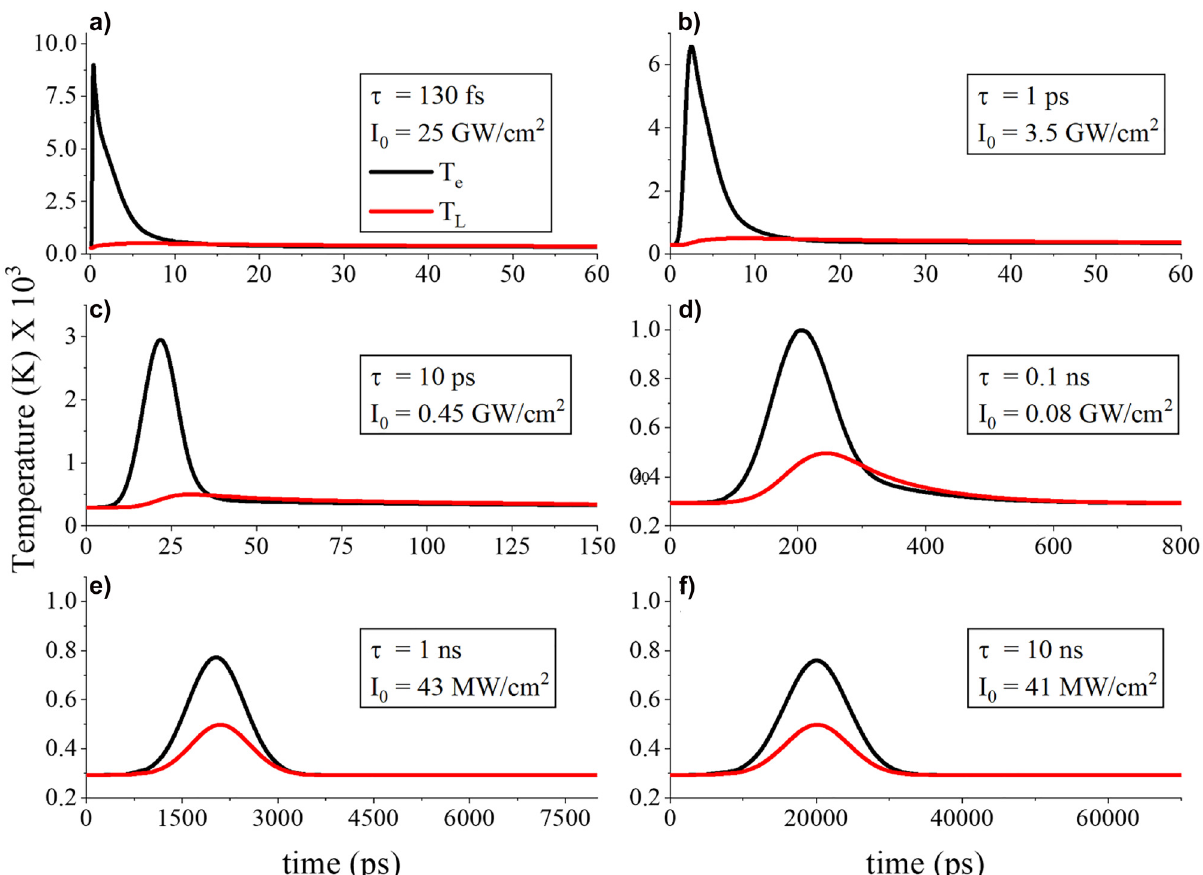
Figure 5: Electron (black lines) and lattice (red lines) temperature dynamics for (a), (b) ultrashort femtosecond, (c), (d) picosecond, and (e), (f) slow nanosecond incident pulse durations. All the data are calculated in the point P shown in the inset of Figure